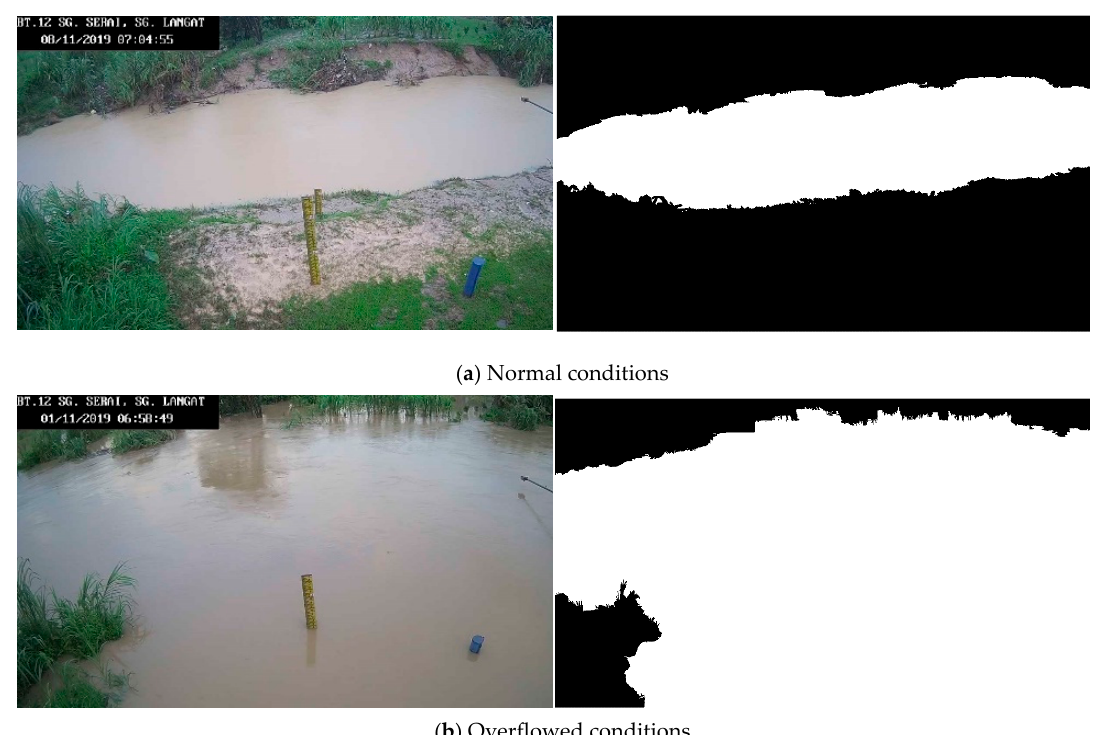
Figure 4. Original and ground truth images during ( a ) normal conditions; ( b ) overflowed conditions.